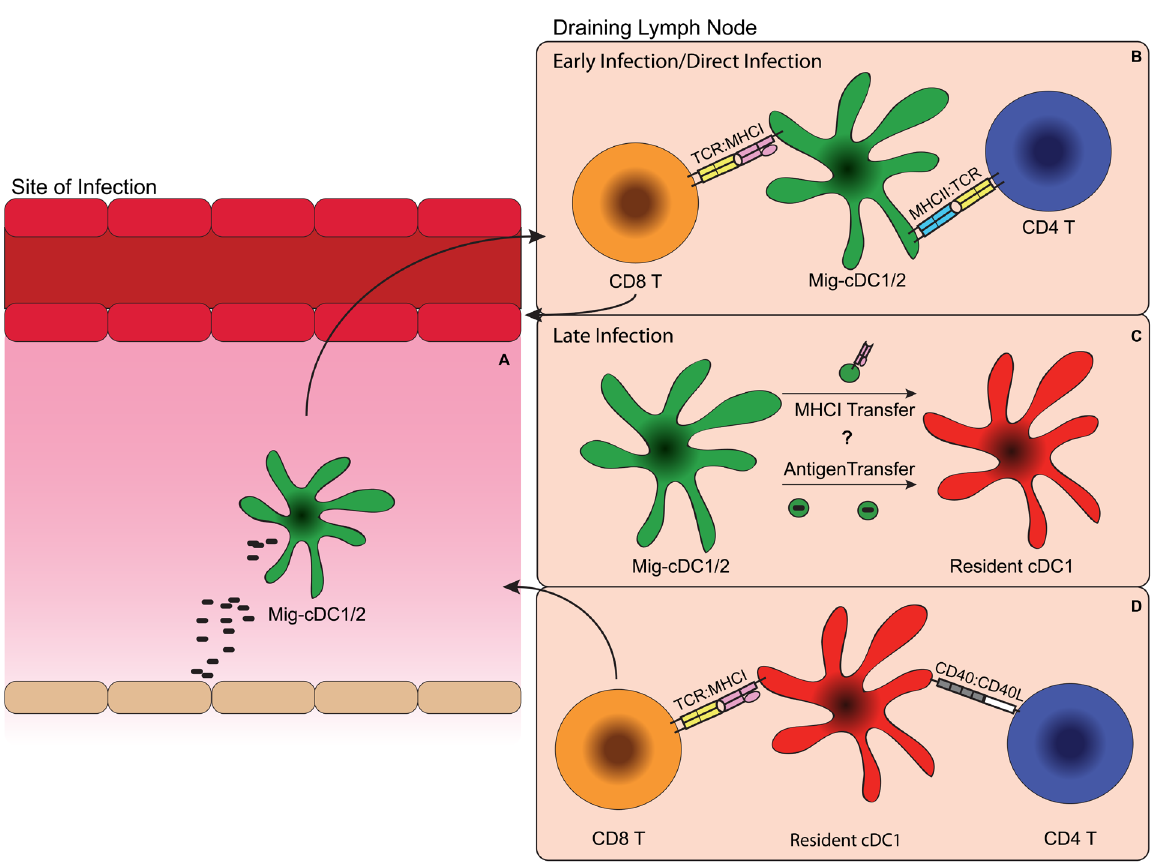
Figure 1. Model for CD8 T cell priming by resident classical CD8 α + dendritic cells (cDC1s). ( A ) Antigen is captured by migratory cDC1s or CD11b + cDCs (cDC2s) at the site of infection by either direct infection or phagocytosis. ( B ) After antigen capture, migratory cDC1s or cDC2s with antigen then migrate to the draining lymph node, where they prime naïve antigen-specific CD4 and possibly CD8 T cells through major histocompatibility (MHC):T cell receptor (TCR) interactions. ( C ) Migratory cDCs transfer antigens to resident cDC1s through either “cross- dressing”, the process by which loaded MHCI is transferred between cell membranes, or by transferring the antigen itself, which is then taken up by the resident cDC1s for cross-presentation. ( D ) Resident cDC1s receive “help” through CD40:CD40L interactions with CD4 T cells, which allow them to prime antigen-specific naïve CD8 T cells through MHCI:TCR interactions. Mig-DC, migratory dendritic